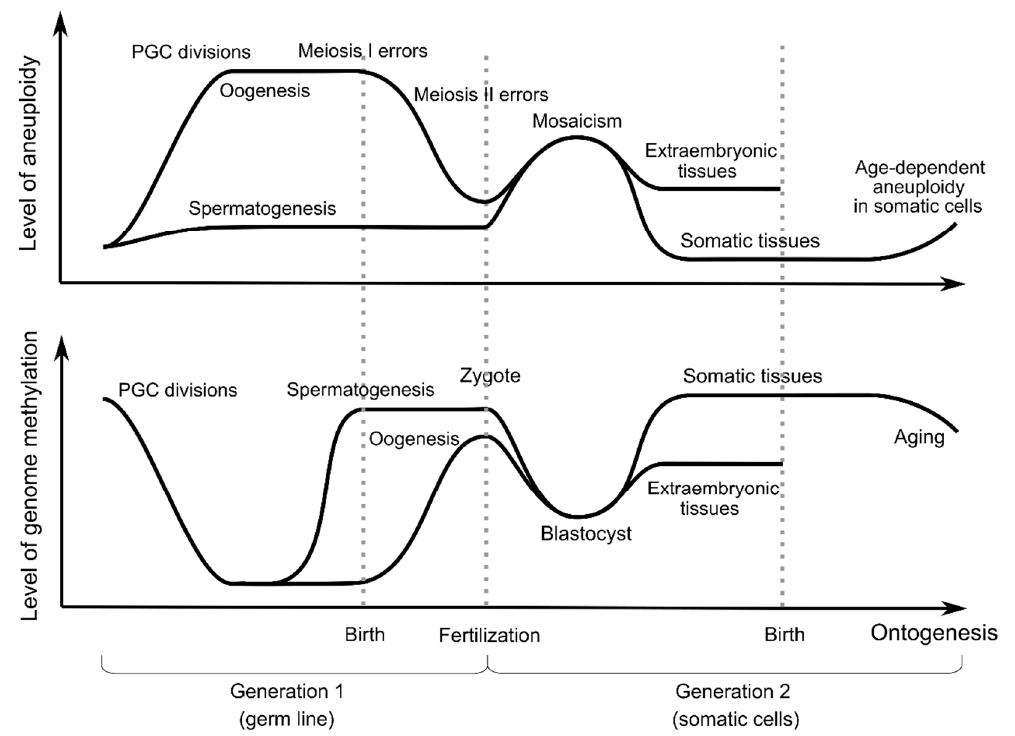
Figure 2. Mirrored dynamics of the levels of genome methylation and aneuploidy in human cells during ontogenesis.